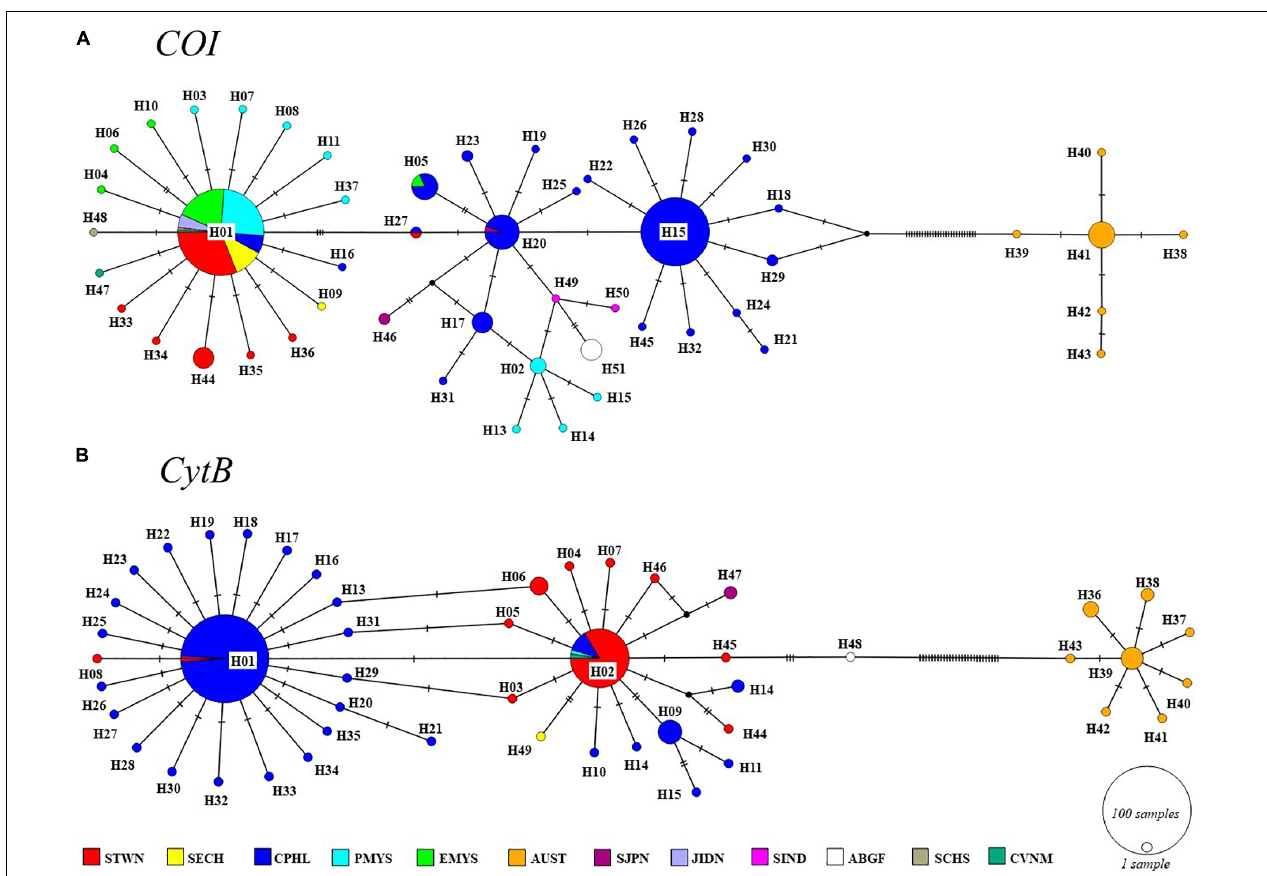
FIGURE 2 | Median-joining (MJ) networks of (A) cytochrome oxidase I (COI) and (B) cytochrome B (CytB) haplotypes of S. leptolepis Tropical Western Pacific (TWP) populations. The sizes of nodes (circles) are proportional to the number of individuals. Black dots represent median vectors (unsampled